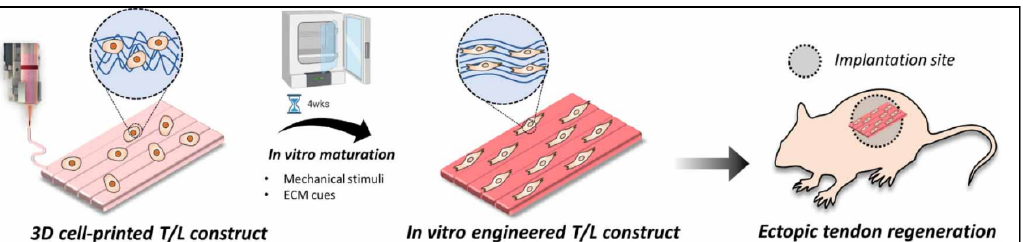
Figure 14. Illustration of how the 3D bioprinted scaffold underwent in vitro maturation for 4 weeks in order to obtain a more aligned and differentiated scaffold. Lastly, the study of ectopic tendon regeneration was performed. Reproduced with permission [81].